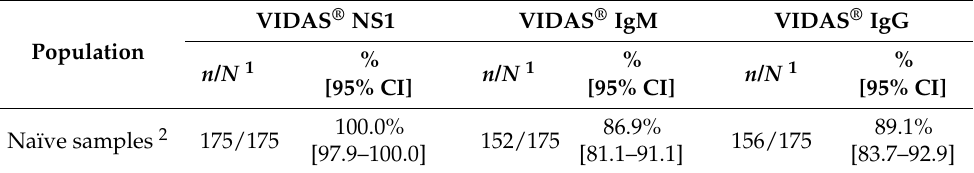
Table 8. Negative agreement of the VIDAS ® Dengue assays with the competitor ELISA tested on study samples defined as